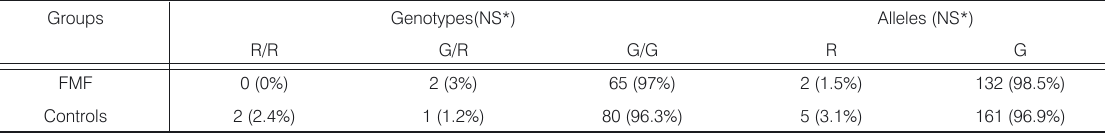
Table 1. ICAM-1 G/R 241 genotype distribution and allele frequencies of FMF patients and healthy controls.